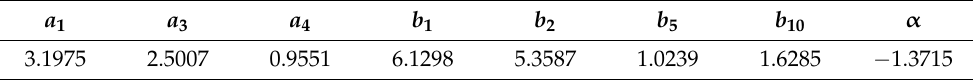
Table 6. Anisotropic and tension–compression asymmetry parameters of the J 0 SMA at 50 ◦ C.